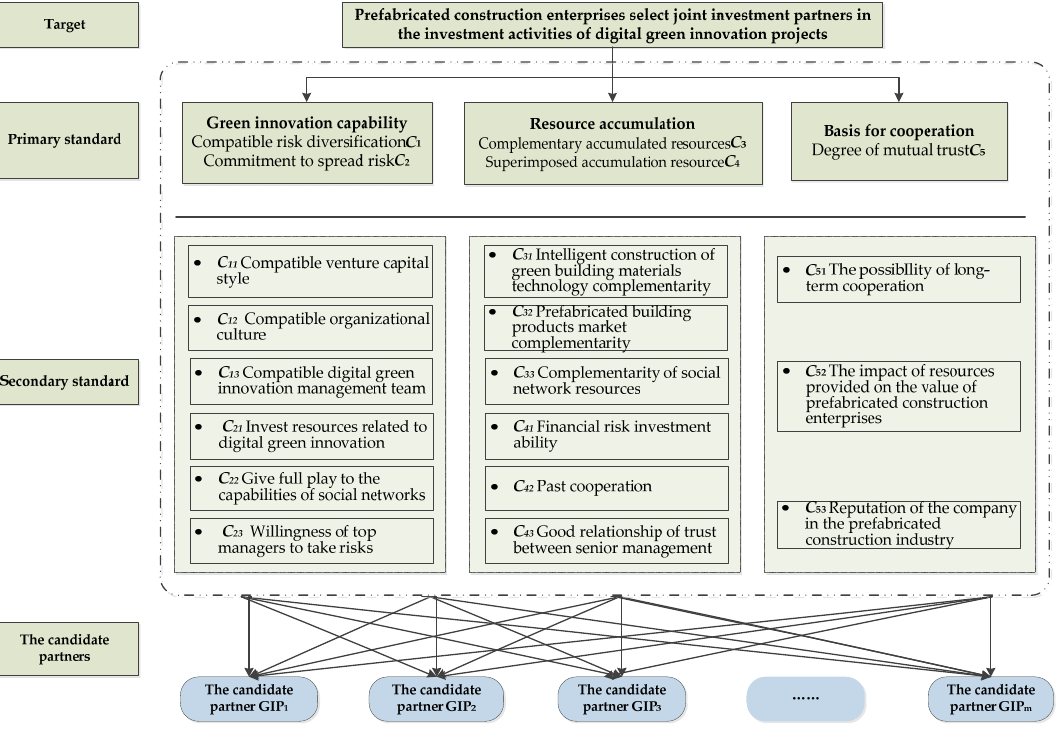
Figure 2. PCEs choose the joint investment partner 3W1H-P research framework.